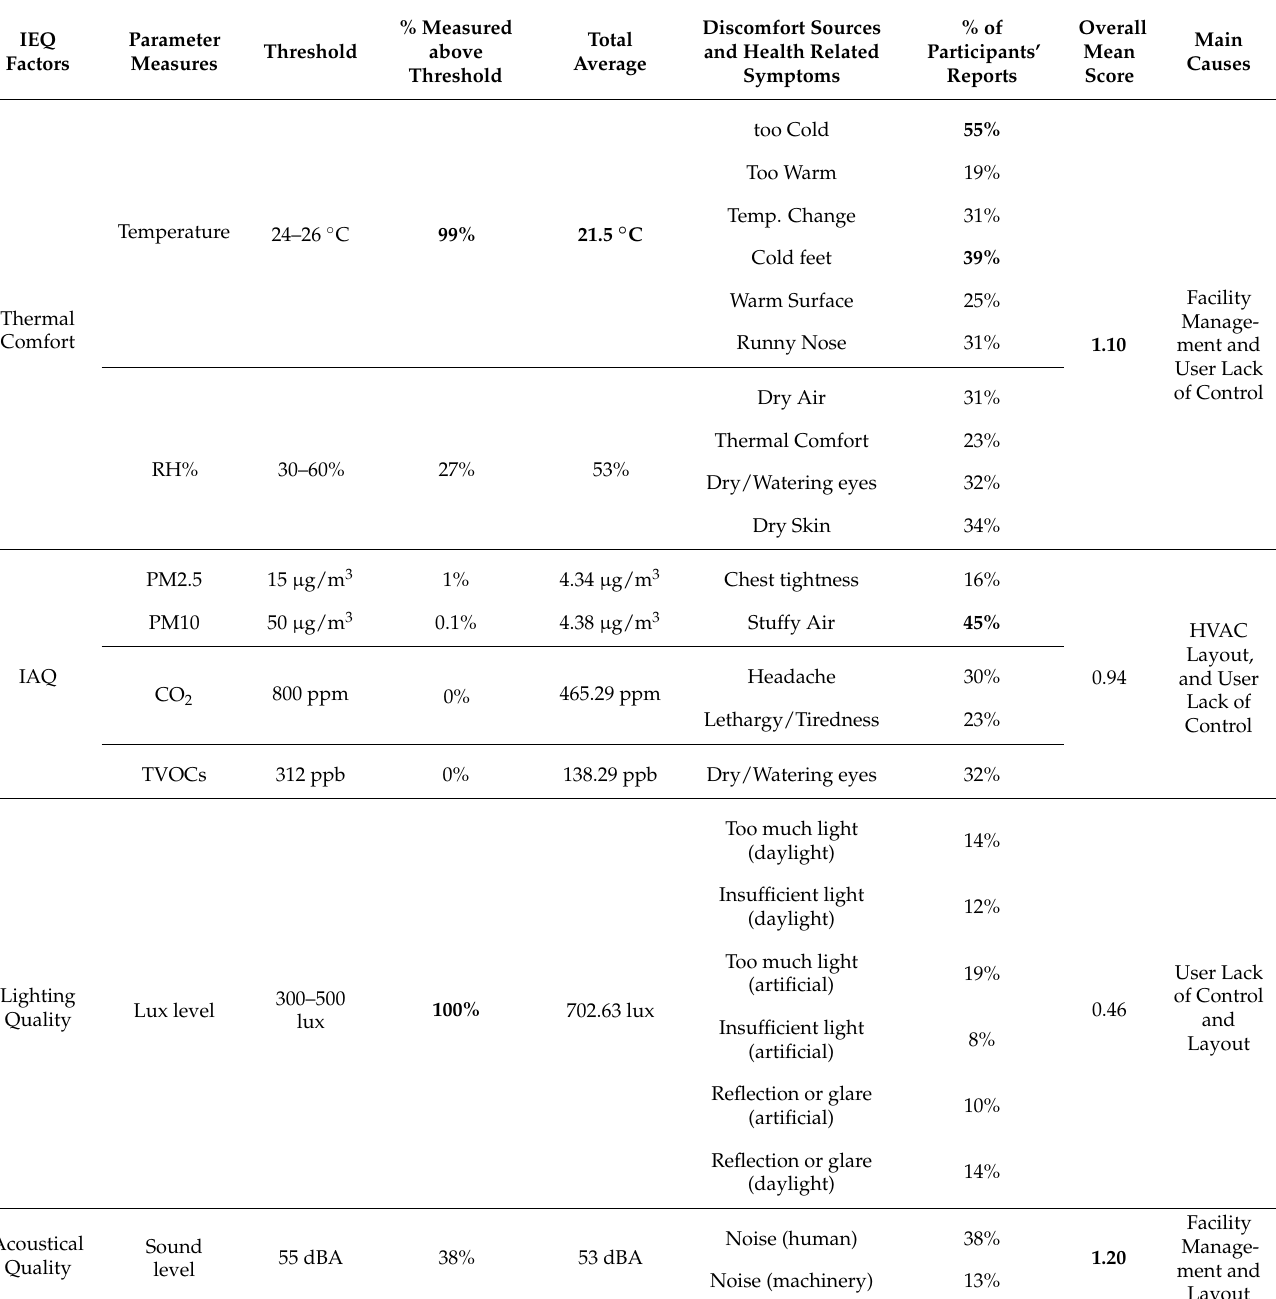
Table 7. Comparative summary of IEQ monitoring and surveying results and main causes (high- lighted in bold are the highest numbers signifying